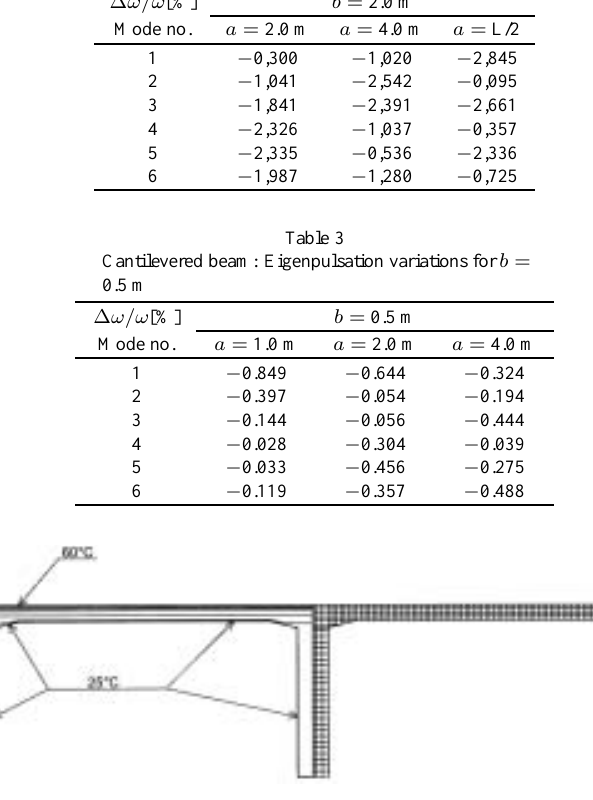
Fig. 5. Thermal map of the cross section after 240 minutes of exposure to